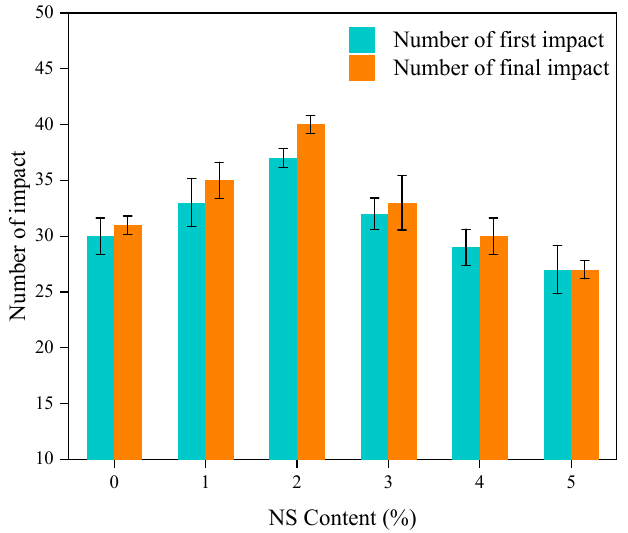
Figure 8. Influence of the content of NS on the number of impacts.